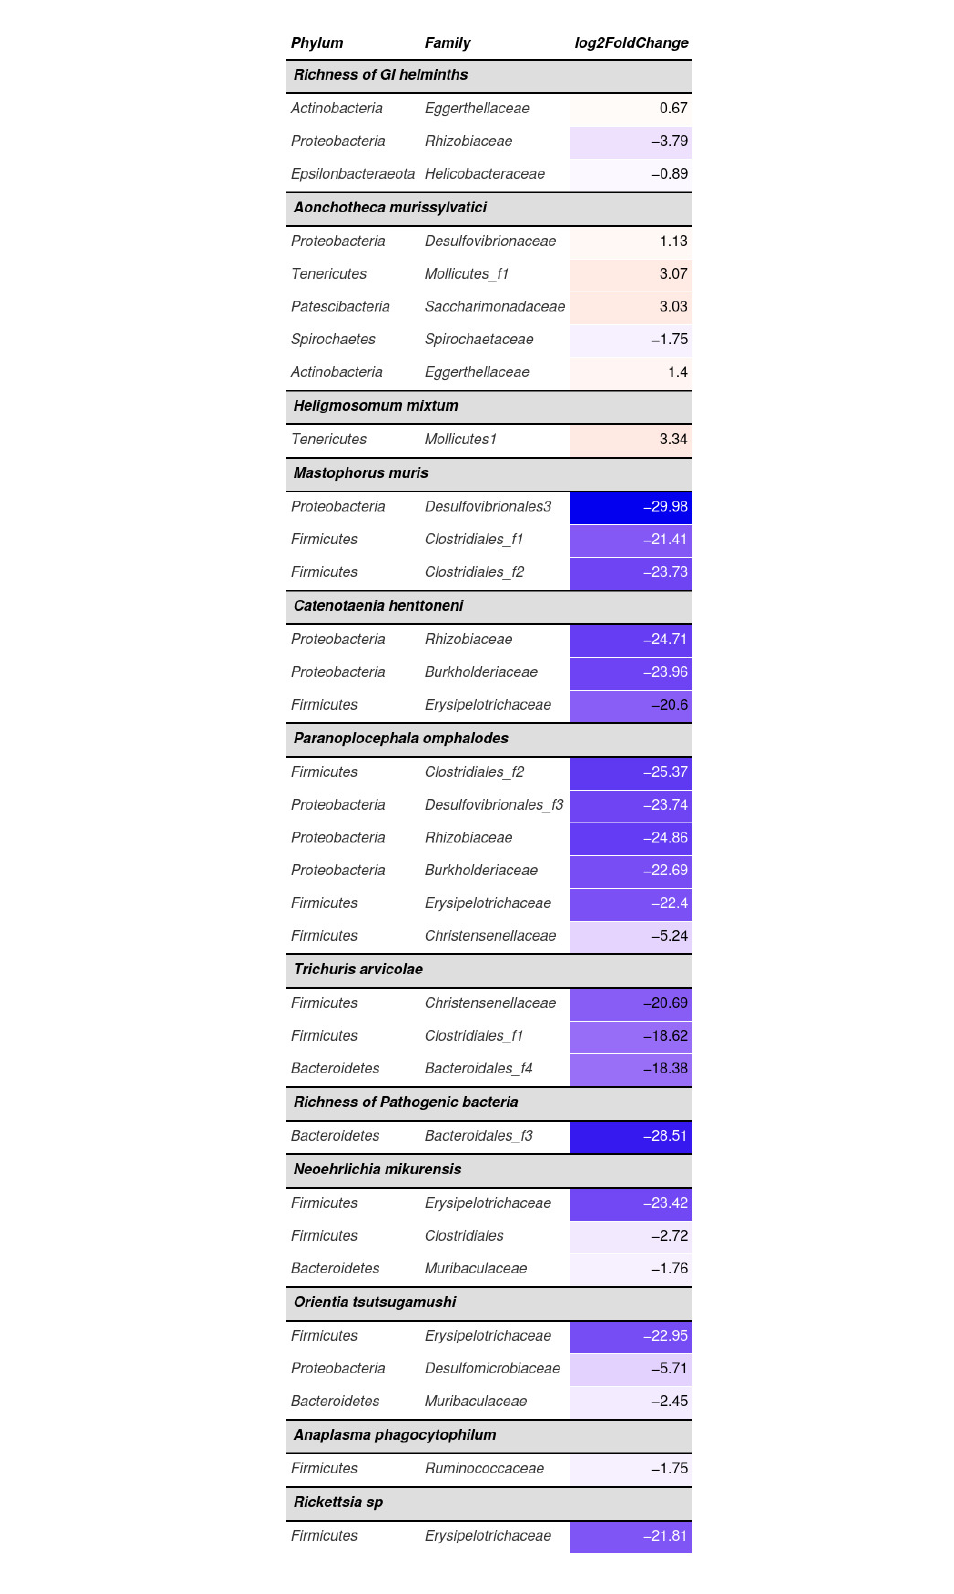
Table 3 - Changes in relative abundance of the gut bacteriota with regard to infectious status (helminths and pathogenic bacteria) and specific richness. The Log² fold change in relative abundance is indicated for significant values only. Negative values are represented with blue colors, positive values with red colors. Higher absolute changes in Log 2 fold are emphasized with darker